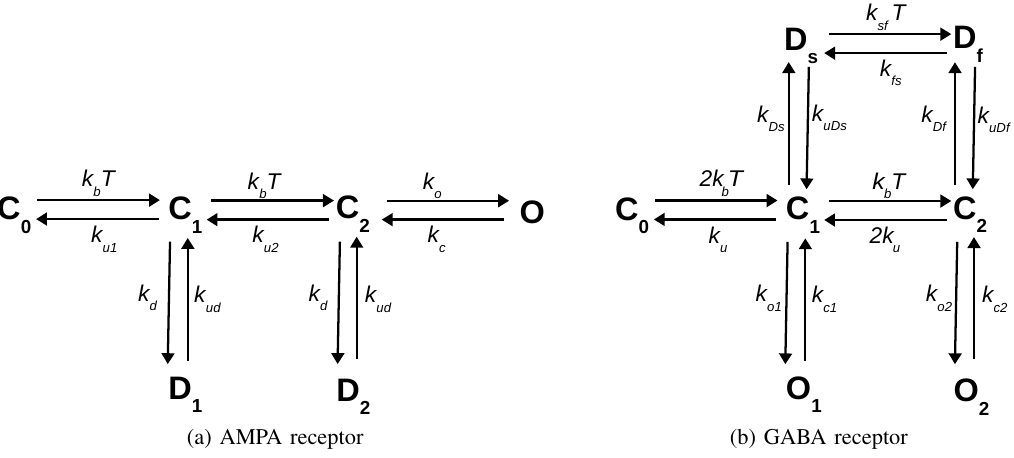
Fig. 1: Kinetic models for ligand-gated